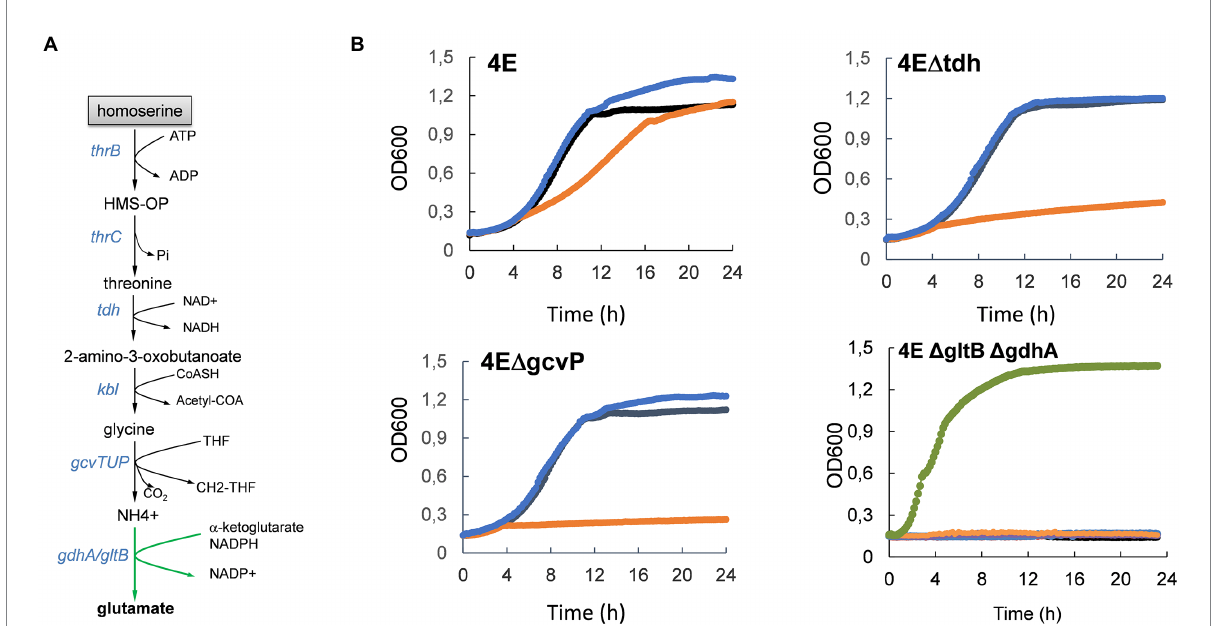
FIGURE 7 Activation of threonine degradation pathway II enables growth on L-homoserine as sole nitrogen source. In (A) is illustrated the metabolic route of L-homoserine degradation via threonine degradation pathway II that encompasses threonine dehydrogenase and 2-amino-3 oxobutanoate CoA ligase encoded by tdh and kbl respectively, followed by the glycine cleavage system encoded by gcvTHP operon. In (B) is shown the effect of loss of the threonine degradation pathway II or of GCS on growth in M9 with NH 4+ , NH 4+ and L-homoserine or L-homoserine alone as nitrogen source. The M9 medium buffered at pH 7.0 with 100 mM MOPS contained 2% (w/v) glucose and growth was carried at 30 ° C in a Biotek. The black line is the growth medium with NH 4 CL (2 g/l) as nitrogen source, the blue line is growth medium M9 with NH 4 CL + 15 mM L-homoserine, orange line is the growth medium with 15 mM L-homoserine and the green line is growth on LB medium. Data are the mean of three technical replicates. 4E = L-homoserine-evolved strain; 4E Δ tdh = − L-homoserine evolved strain deleted of tdh, 4E Δ kbl = L-homoserine evolved strain deleted of kbl , 4E Δ gcvP = L-homoserine evolved strain deleted of gcvP